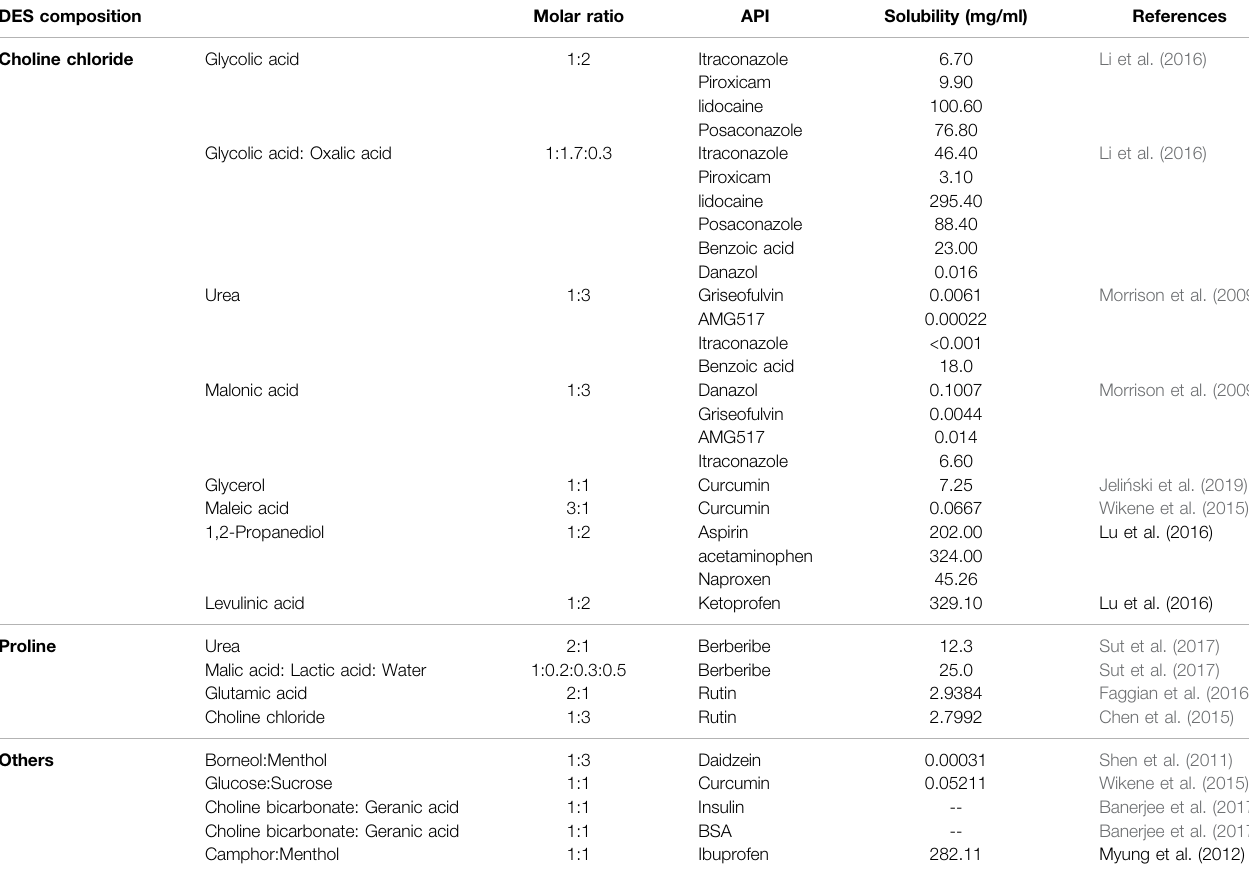
TABLE 2 | The composition, molar ratio and API solubility of DESs as new solvents for APIs. DES composition Molar ratio